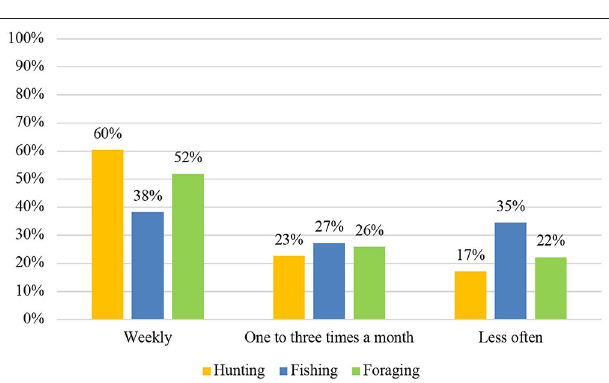
Foraging The majority of participants reported they forage (66%) and have members in their household that forage (59%) including partners (63%), friends (50%), parents (45%), extended family (28%), siblings (20%), and grandparents (11%). Significant differences were found for those that reported they forage based on generation ( p = 0.0035) and gender ( p = 0.0040).